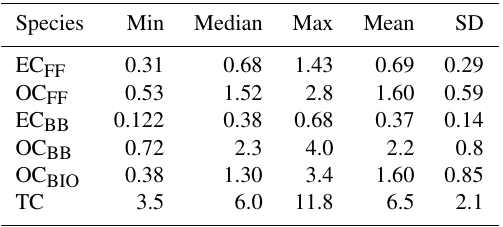
Table 2. Range, median, mean with standard deviation (SD) of the atmospheric concentrations for the apportioned EC and OC from FF combustion (EC FF and OC FF , respectively), EC and OC from BB (EC BB and OC BB , respectively), OC from biogenic sources (OC BIO ) and for the measured TC inµgm − 3 for the PM 2 . 5 size